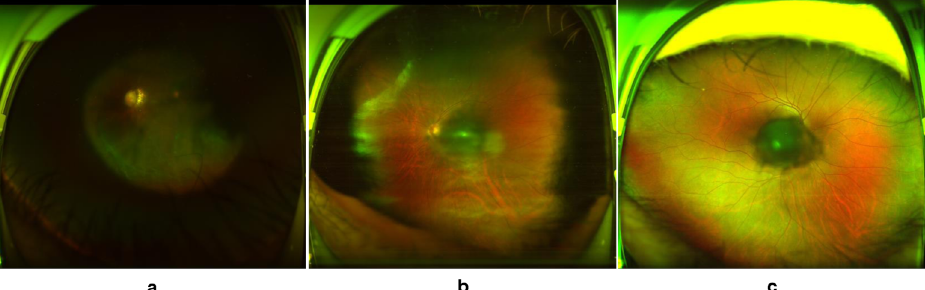
Fig. 6 Typical examples of poor-quality ultra-wide fi eld fundus images. a Obscured area over one-third of the image. b Obscured macular area. c Obscured optic disc